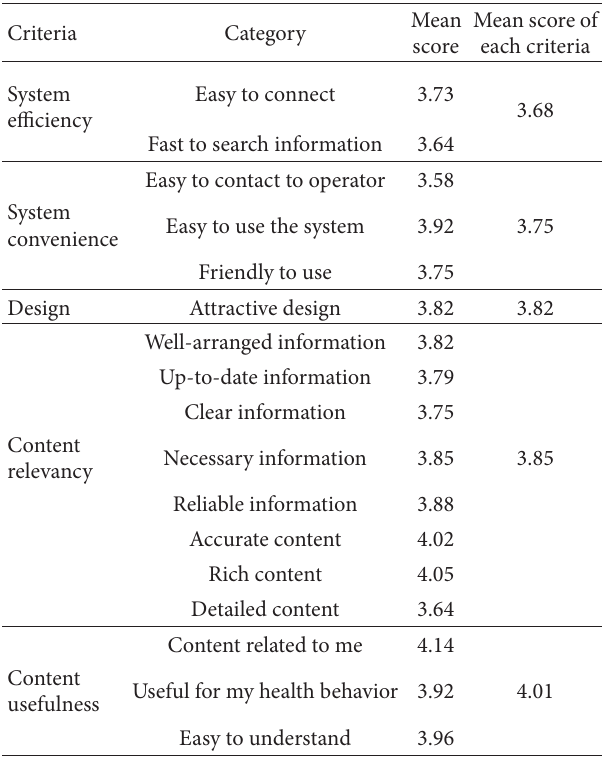
T 2: User satisfaction with online program for hepatitis